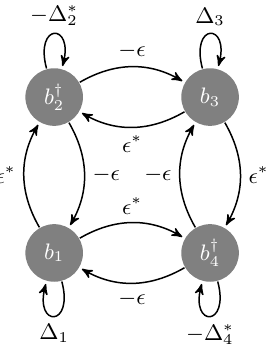
FIG. 7. Graph for multimode squeezing. This graph represents the mode couplings in Fig. 4 in the main text. For simplicity, we assume identical